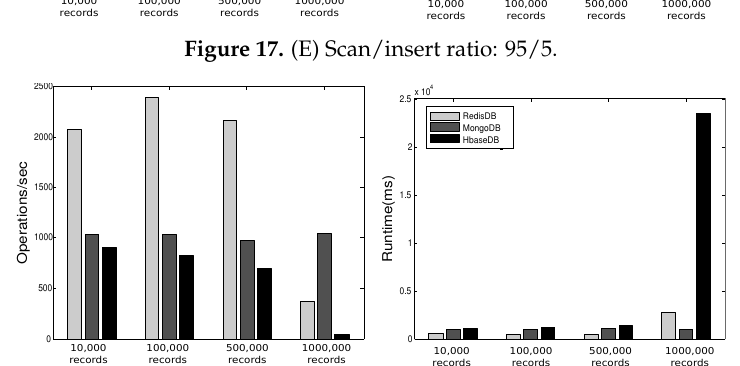
Figure 17. (E) Scan/insert ratio: 95/5.